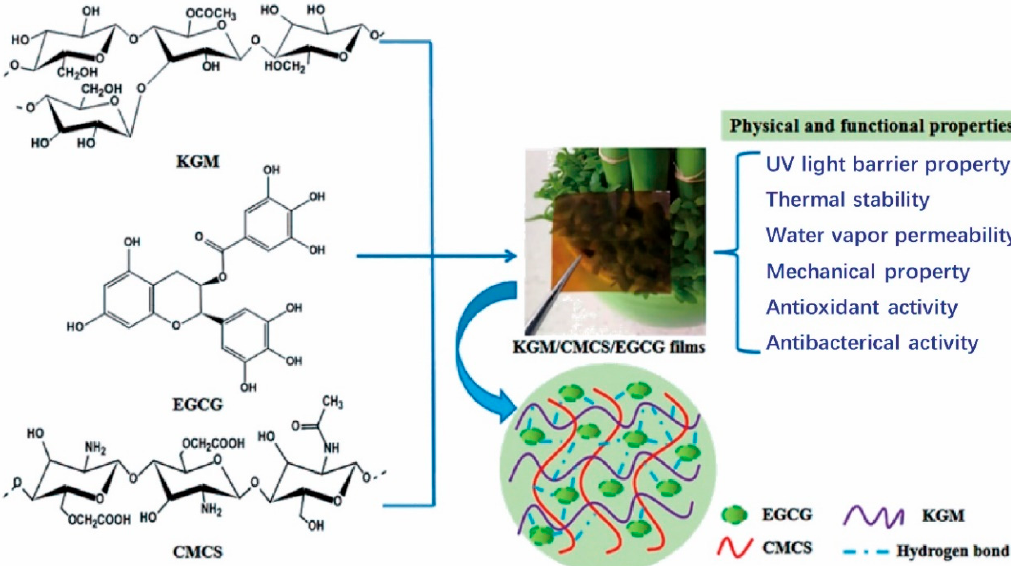
Figure 8. Schematic illustration of epigallocatechin gallate (EGCG) incorporated carboxymethyl chitosan (CMCS) / konjac glucomannan (KGM) biocomposite films [58].